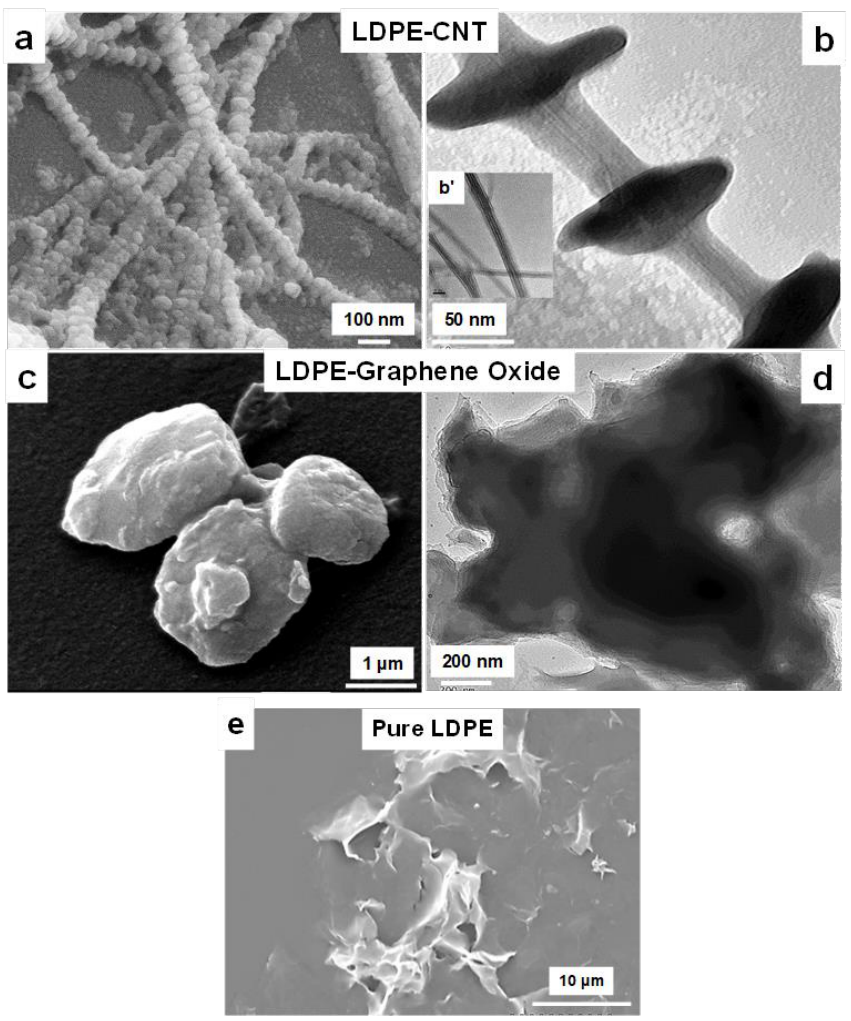
Figure 1 . SEM ( a ) and TEM ( b ) micrographs of LDPE-CNTs, while ( c , d ) are corresponding micrographs of LDPE-GO. INSET images are AFM data of pure GO. Pure LDPE crystallized under similar conditions is given as ( e ). The magnifications in the micrographs are as: a, b and b’ (INSET): 90 k; c: 20 k; d: 60 k; e: 3 k. The SEM chamber pressure varied from 1.4 × 10 −6 mbar – 4 × 10 −6 mbar.